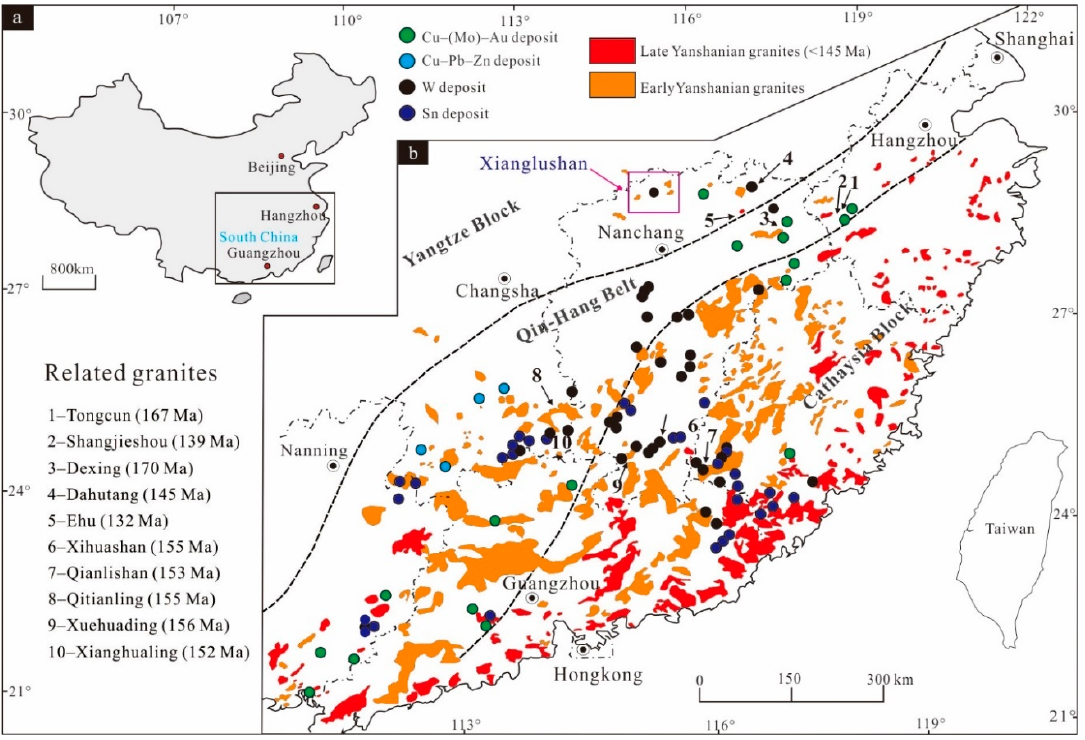
Figure 1. ( a ) Sketched map of China. ( b ) Simplified geologic map, showing the distribution of Yanshanian granites in South China and its associated ore deposits (modified after [18,20]).